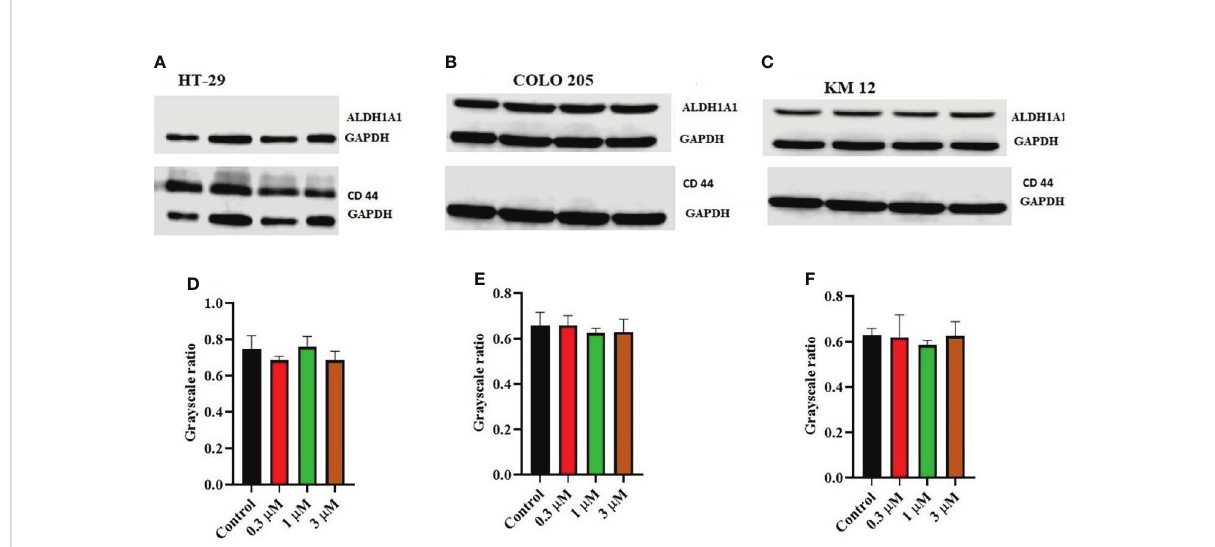
FIGURE 3 Effect of ITH-6 on the expression of ALD1HA1 and CD44: The effect of ITH-6 on the expression of ALDHA1 and CD44 on (A) HT-29 (B) COLO 205, and (C) KM 12 cells were tested after the cells were treated with 0.3, 1, and 3 m M of ITH-6 for 72 hours. Relative quanti fi cation of the effect of ITH-6 on (D) CD44 in HT-29 and ALDH1A1 in (E) COLO 205 and (F) KM 12 cells. The expression levels of the target proteins were normalized to GAPDH. Equal amounts of total cell lysates were used for each sample, and a Western blot analysis was performed. The fi gures are representative of three independent